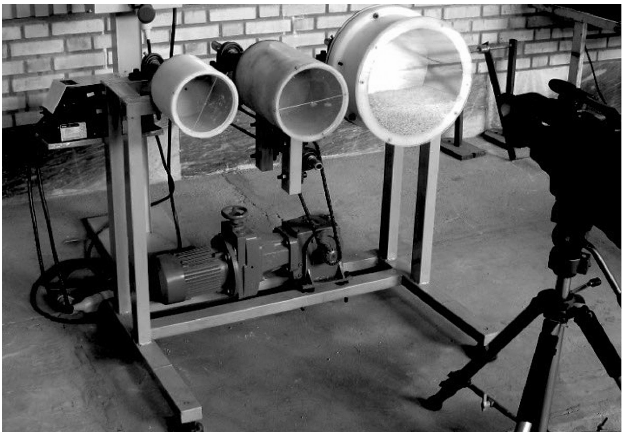
Fig. 3: The device used in this study which was established by g hanbari (2008).